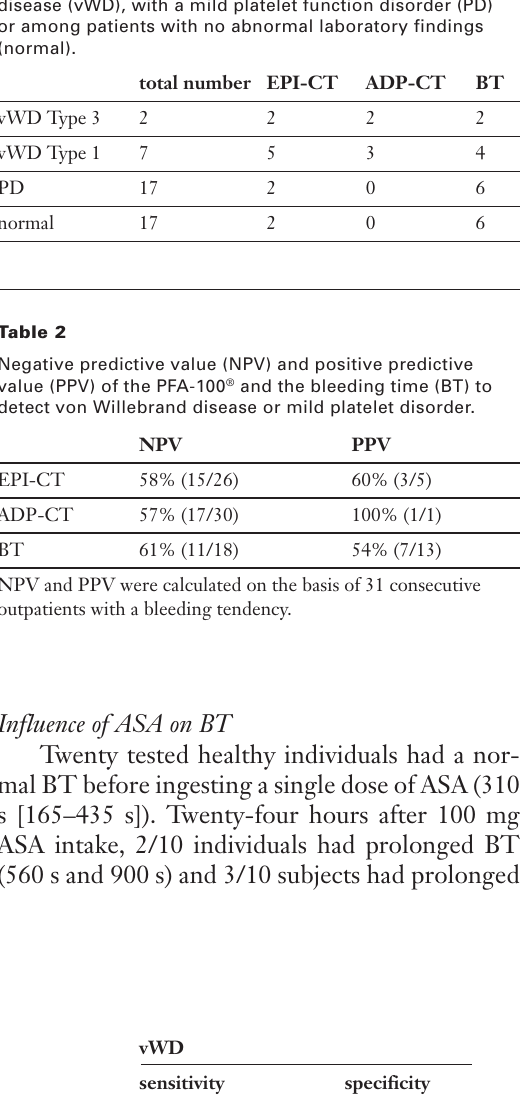
Influence of daily ASA ingestion during 10 consecutive days on EPI-CT. The EPI-CT was measured in 10 healthy subjects each before ASA intake (day 1) and after 10 days (day 10) of in- gestion of 100 mg (squares) or 300 mg (circles) of ASA and thereafter on days 12, 15 and 20. Squares and circles denote mean values, vertical bars denote SEM.